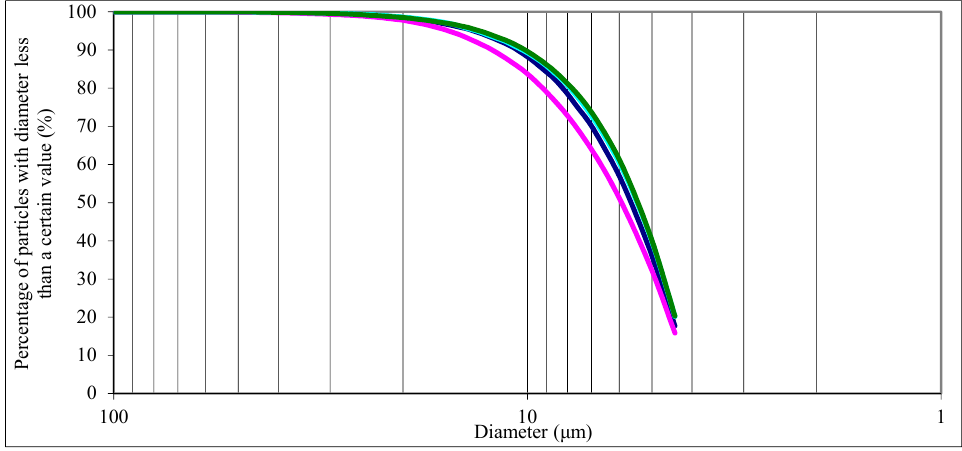
where Q is the stream flow (m 3 · s − 1 ), TSS is total suspended solids (mg · L − 1 ), THg is the total concentration (ng · L − 1 ).